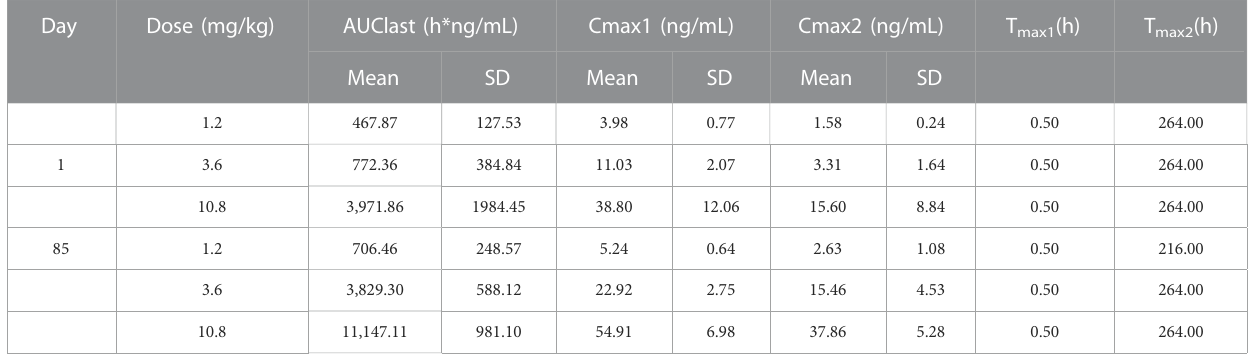
TABLE 4 Mean TK parameters in rats after intramuscular injection of